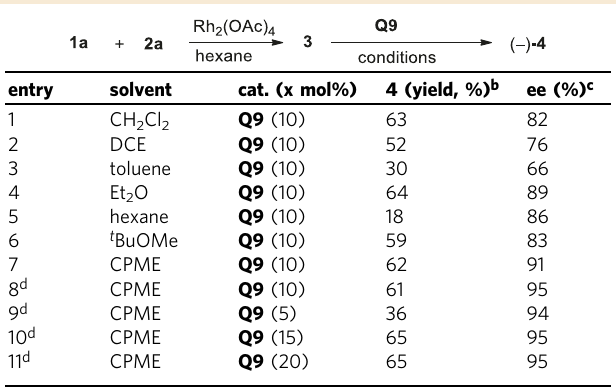
Fig. 4 Screening the chiral organo-catalysts. Conditions: 1a (0.3 mmol, 1.5 eq.), 2a (0.2 mmol, 1eq.) and Rh 2 (OAc) 4 (2 mol%) in hexane (2 mL) stirred at rt. for 12 h under N 2 ; Then, removing the solvent and DCM (2.0 mL), Q9 (10 mol%) were added. The mixture was stirred for another 72 h. Isolated yield for two steps. Ee values were determined using chiral HPLC. Table 2 Selected optimization of enantioselective synthesis a